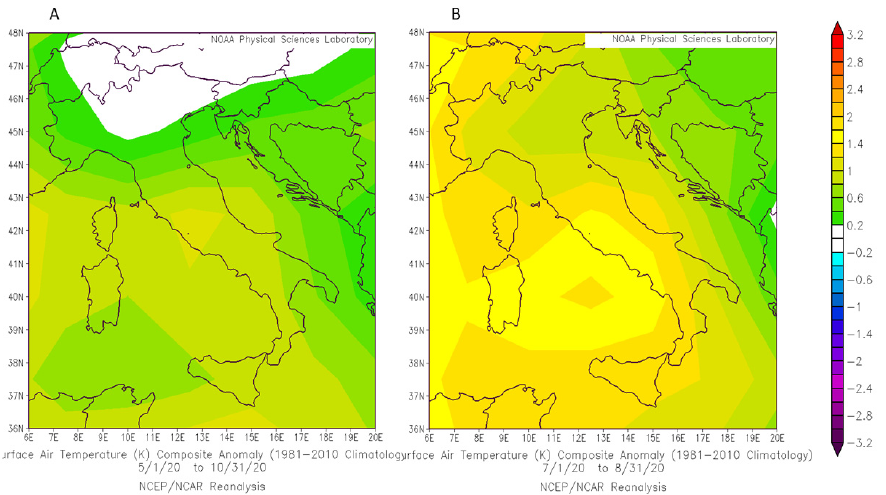
Figure 1. Air temperatures anomalies in Italy during the period May–October 2020 ( A ) and during the period July-August 2020 ( B ) compared to the climatology 1981–2010. Data obtained from https://psl.noaa.gov/cgi-bin/data/composites/printpage.pl, accessed on 6 April 2021.